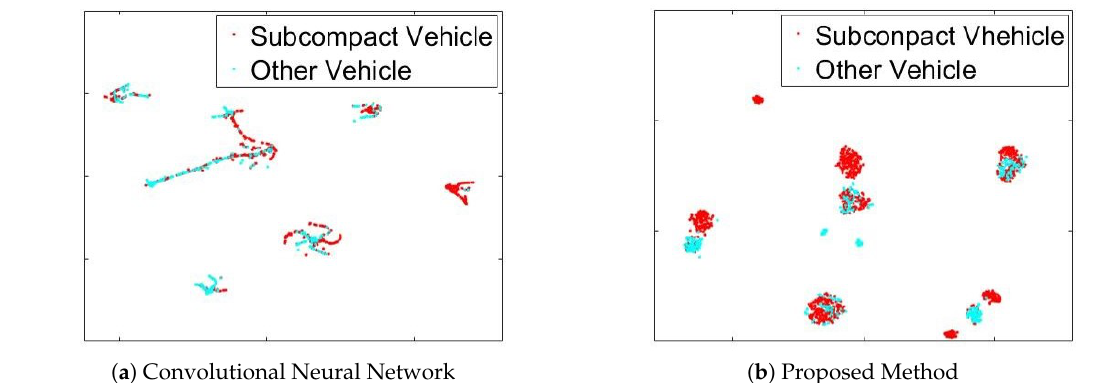
Figure 13. Probability Visualization using t-Stochastic Neighbor Embedding (t-SNE)